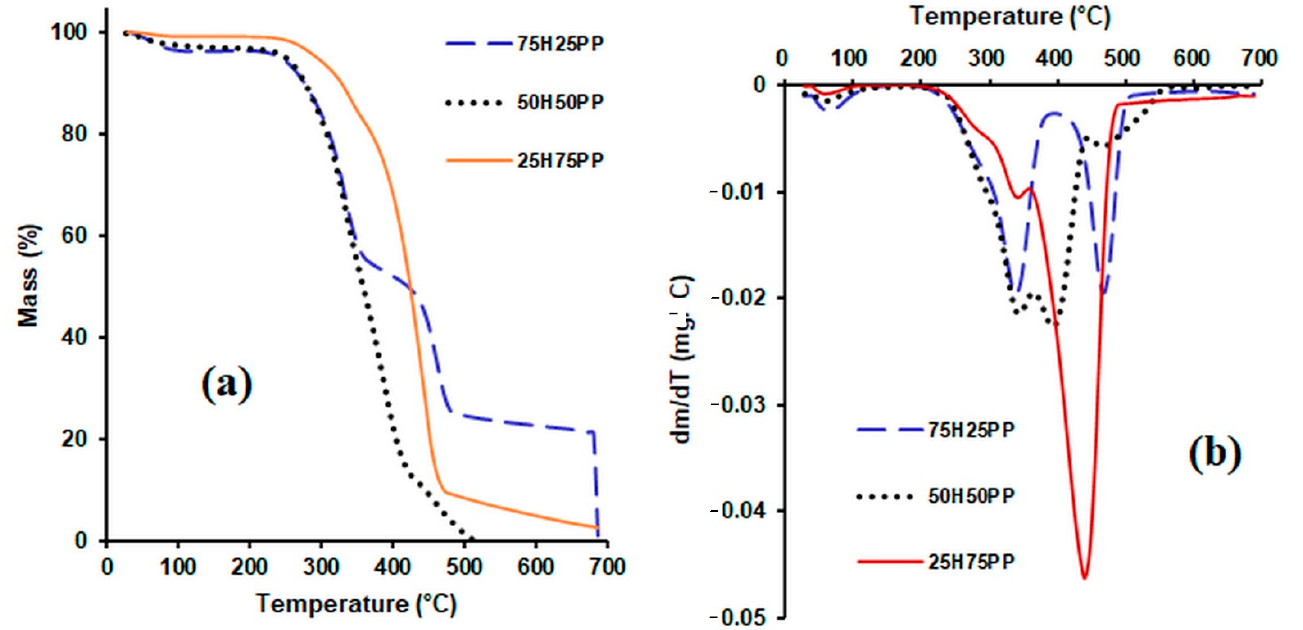
Figure 5. TG curves ( a ) and DTG curves ( b ) for composite materials consisting of hemp fibres and polypropylene fibres.